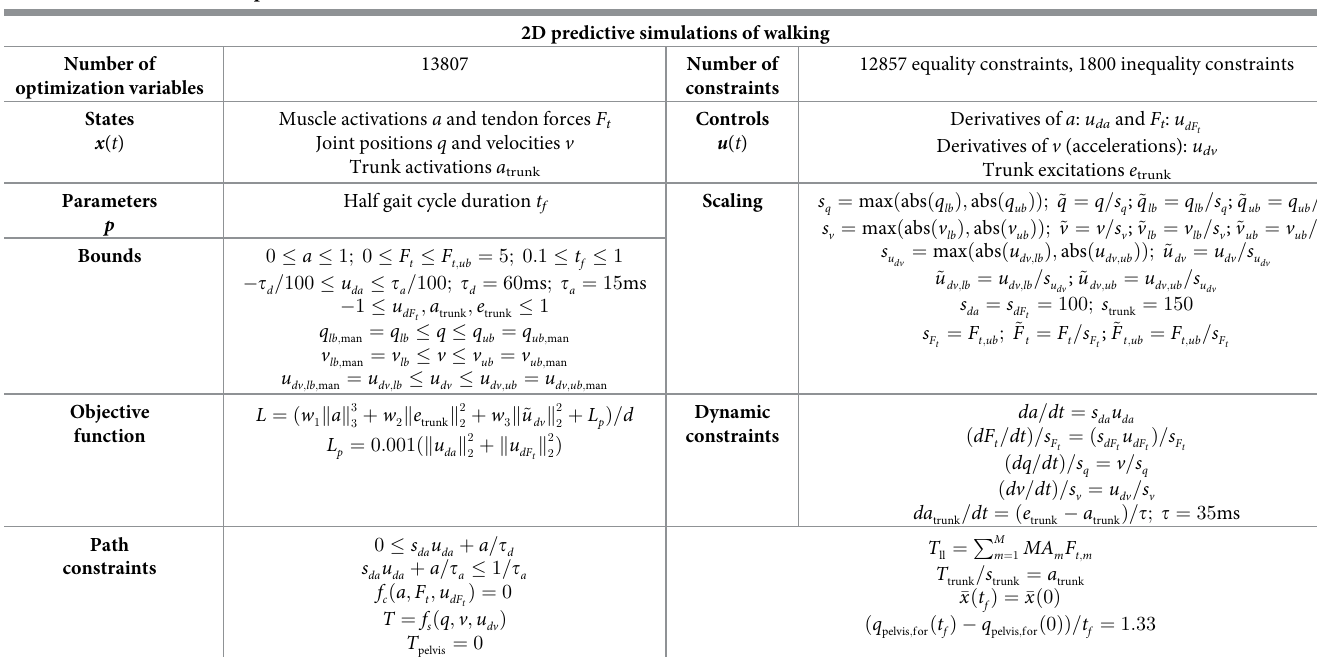
Table 2. Formulation of example